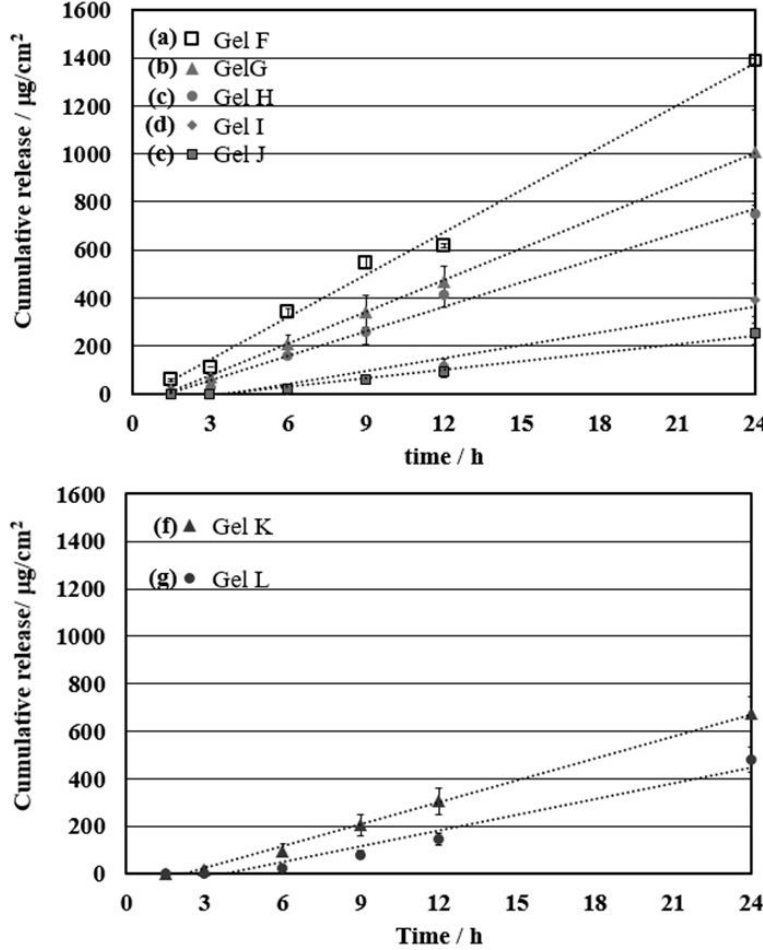
Figure 6. In vitro cumulative release profile of ibuprofen from PS-4VP gel by various feeding ratio of 4VP from 2–5 mol %; Gel F ( a ), Gel G ( b ), Gel H ( c ), Gel I ( d ), Gel J ( e ) and PS-VBAC gel by various feeding ratio of VBAC 0.5 and 1 mol %; Gel K ( f ) and Gel L ( g ) ( n = 3). Table 3. The skin permeation parameters of ibuprofen from PS-4VP gel (gel F–J) and PS-VBAC (gel K and L).